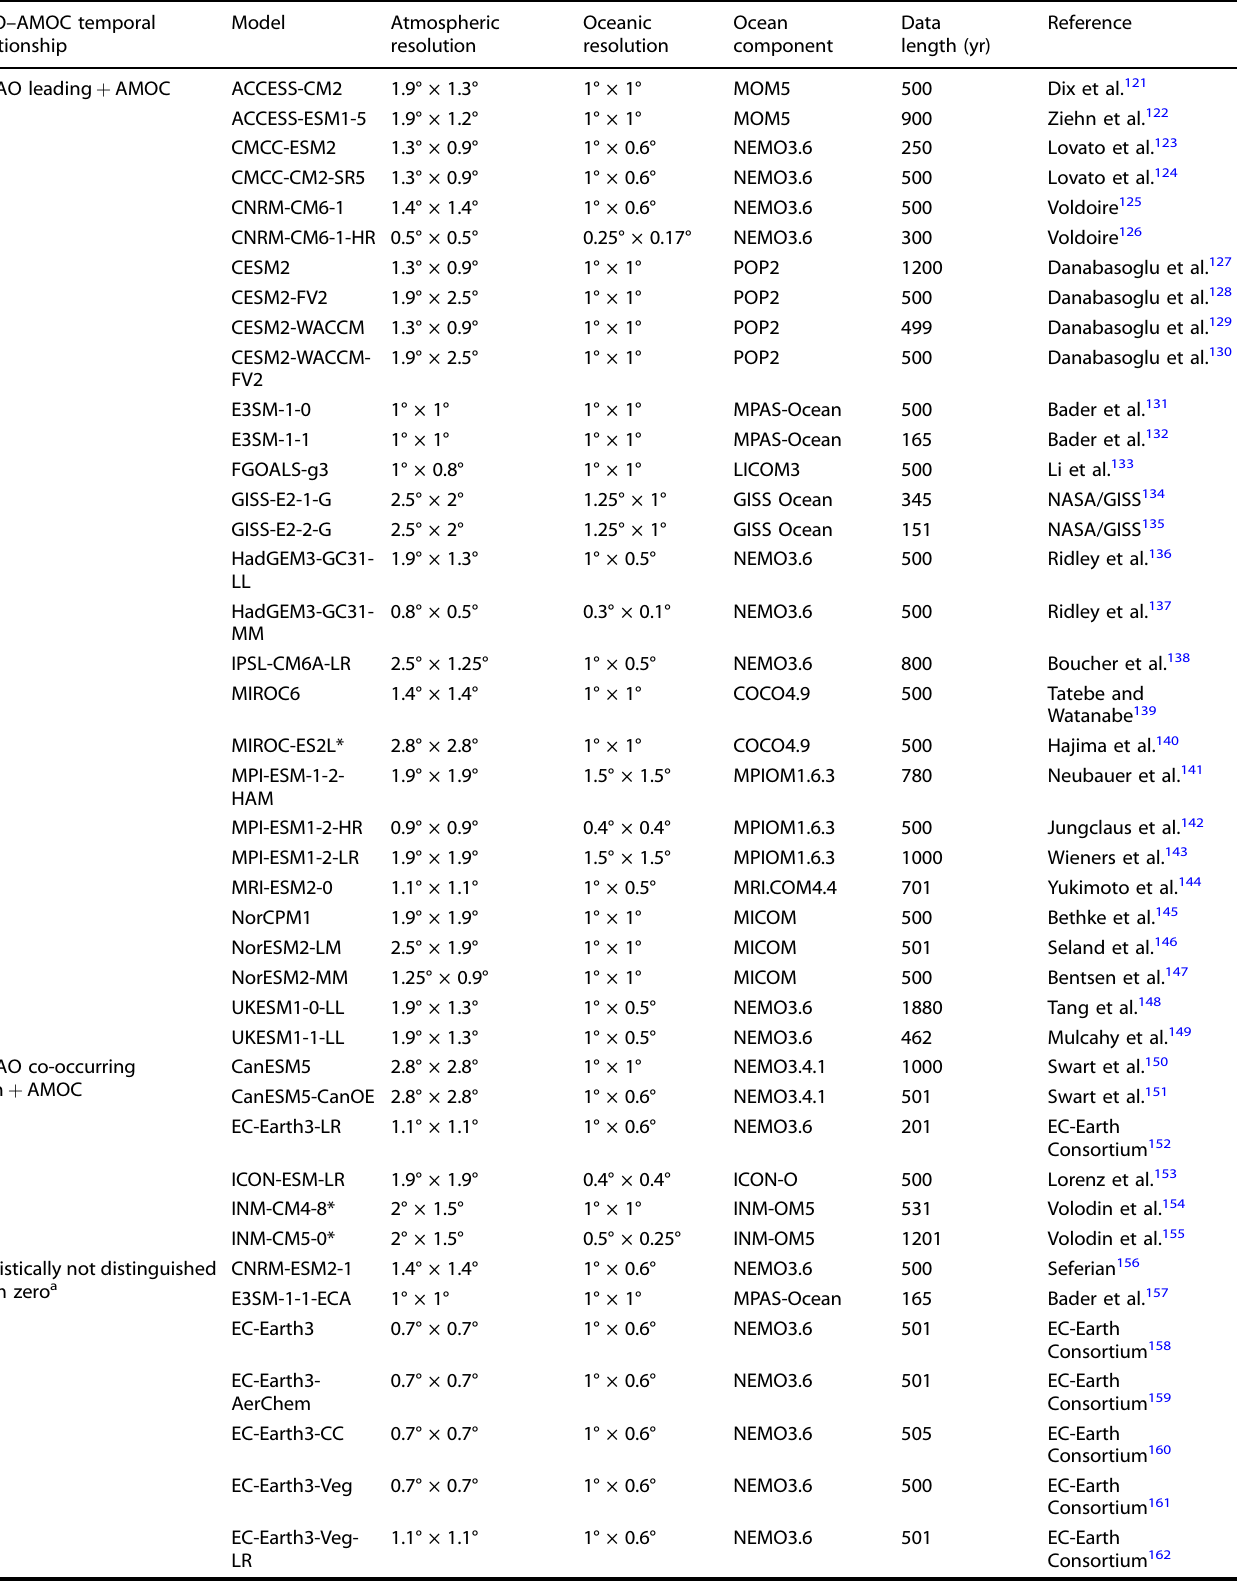
Table 1. CMIP6 model con fi gurations and classi fi cation based on the temporal relationship between the NAO and AMOC. NAO – AMOC temporal